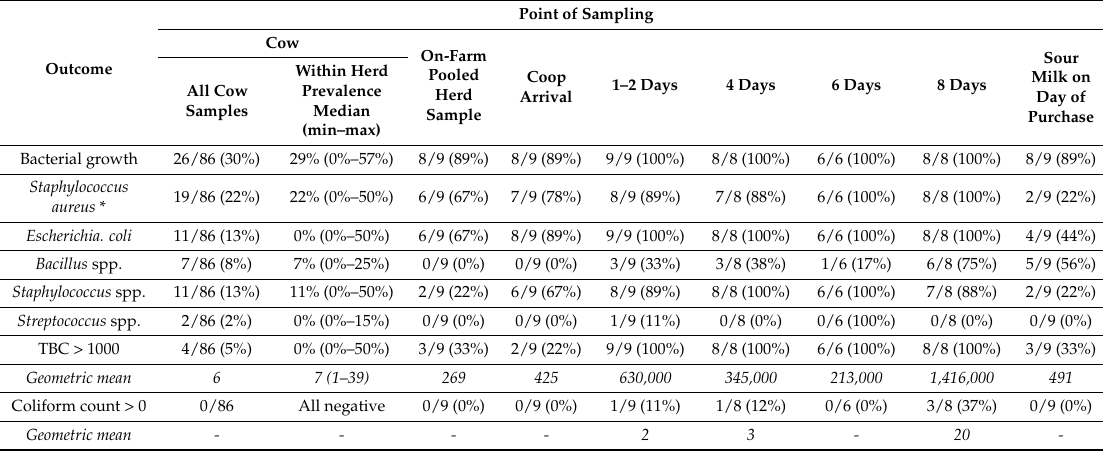
Table 1. Table showing microbiological test results for milk sampled at different points along the smallholder fresh milk value chain in Western